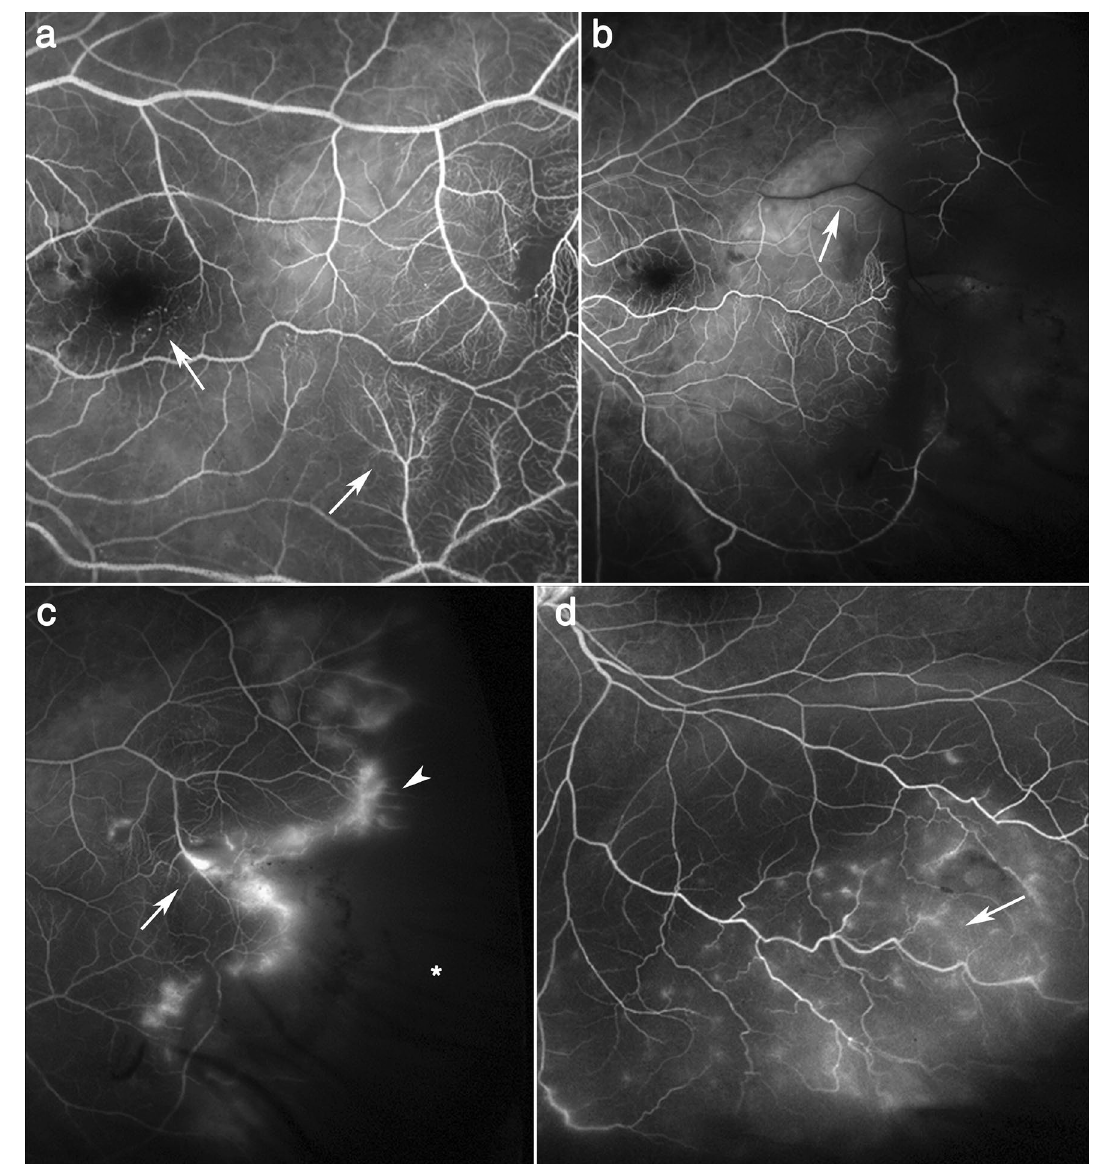
Figure 4. Representative images of perfusion impairment and vascular abnormalities detected in preoperative ultra-widefield fluorescein angiography in rhegmatogenous retinal detachment. Ultra-widefield fluorescein angiography was performed on eyes with rhegmatogenous retinal detachment before reattachment. Arrows indicate the vascular abnormalities that RRD eyes have. ( a ) Capillary stasis shown on the macula and periphery. ( b ) Delayed arteriovenous transit. ( c ) Neovascularization (arrow) marginal leakage (arrowhead) and peripheral nonperfusion (asterisk). ( d ) Vascular tortuosity and diffuse paravascular